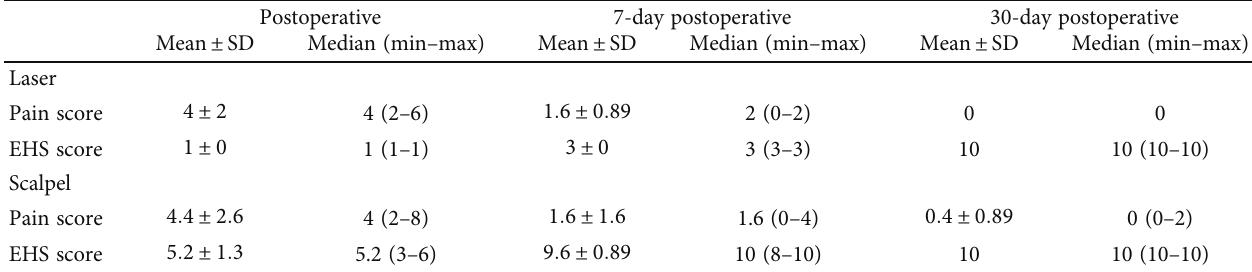
Table 1: Summary of outcome